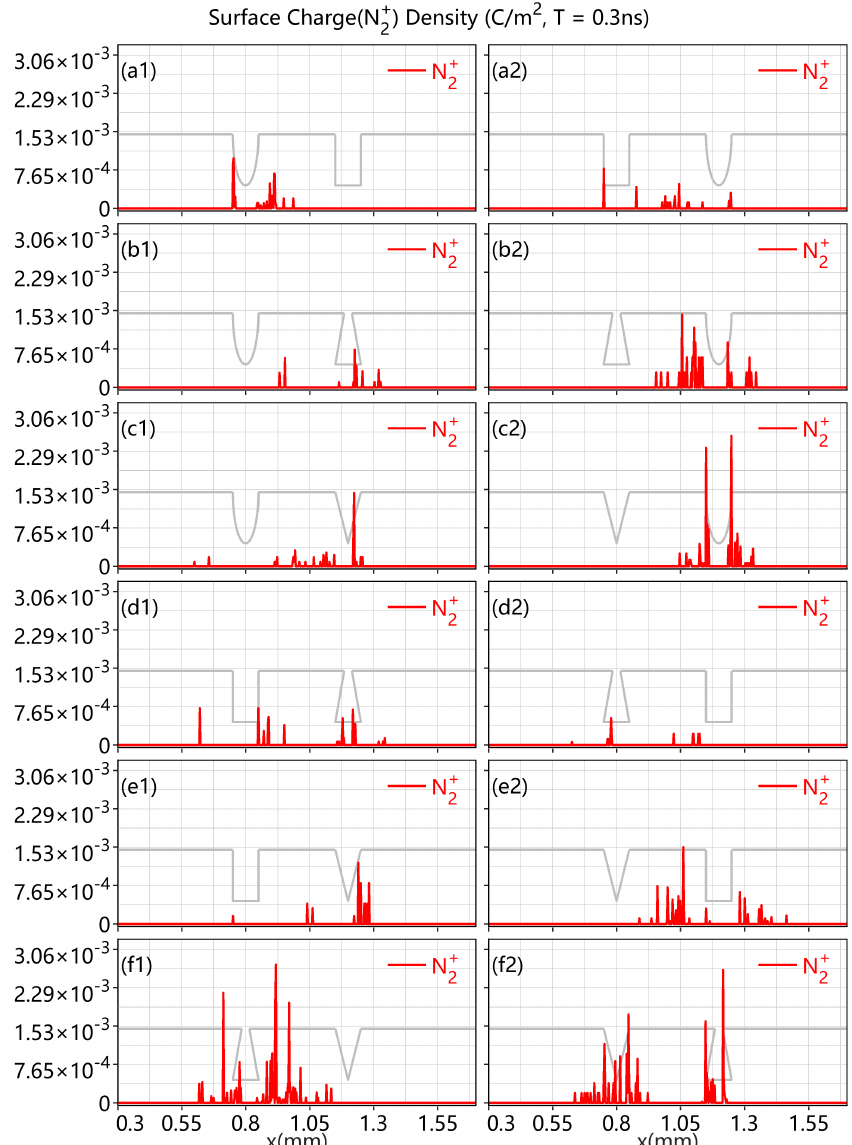
Figure 3. Surface charge densities of N + conditions as in Figure